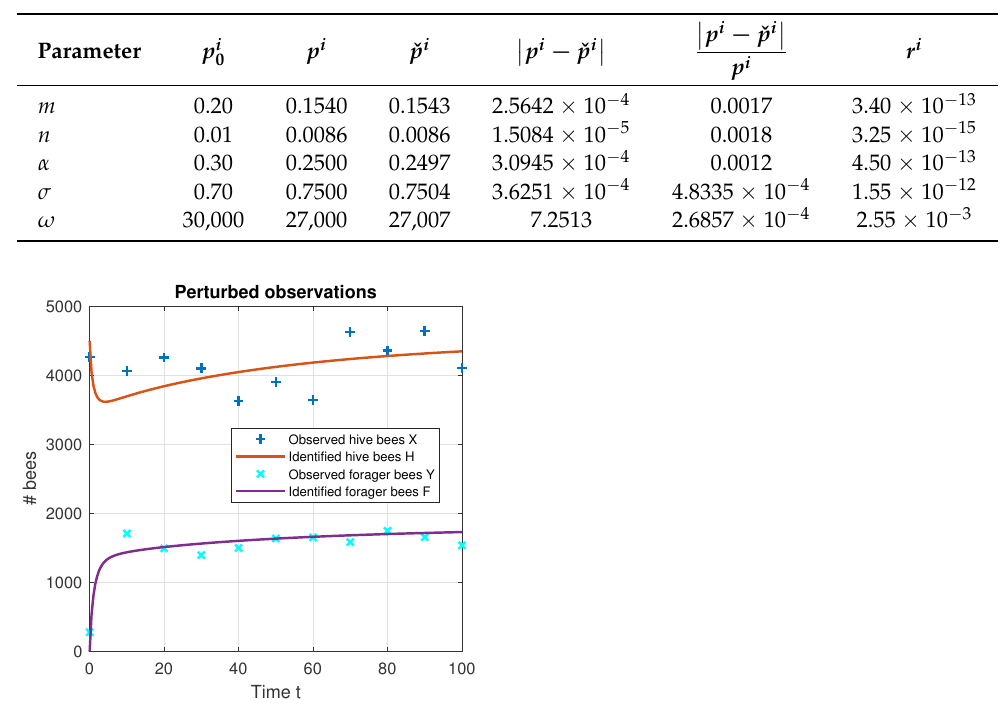
Table 6. Test with Caputo model (3a)–(3c) and perturbed observations with 20% noise.